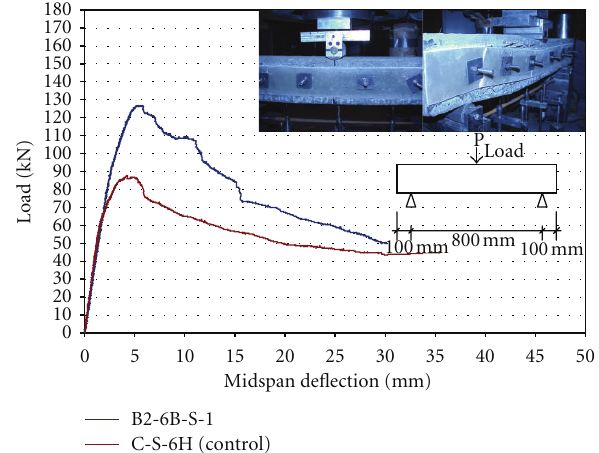
Figure 36: Load versus midspan deflection of RC beam B3-S-3.